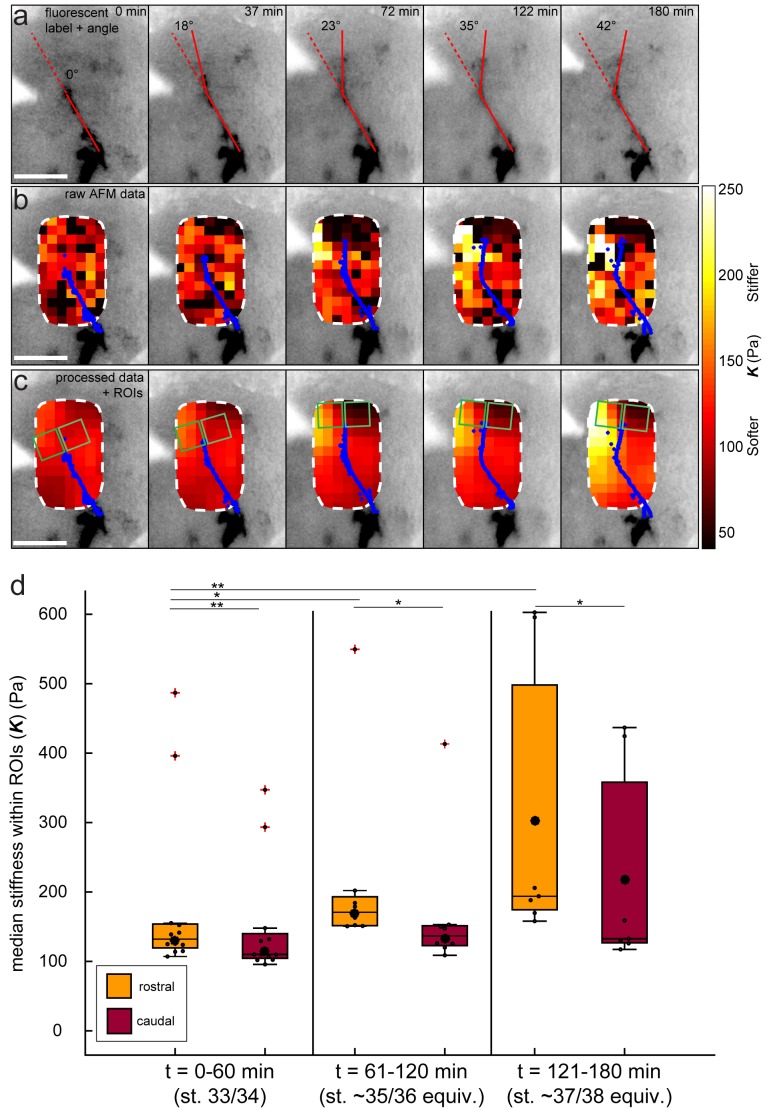
Data processing for tiv-AFM experiments.(a–c) Same Xenopus embryo shown in Figure 2a–b. (a) Inverted epifluorescence raw images of OT axons (black) acquired during tiv-AFM measurements, labelled with membrane-bound GFP under the control of the cell type-specific ath5 promoter, showing turn angles (overlaid red lines). (b) Overlaid tiv-AFM-based colourmaps (‘stiffness maps’), encoding raw values of apparent elastic moduli K, with OT axons outlined in blue. Black squares denote points where AFM data were not analysable. (c) Final stiffness maps used for mechanical gradient quantification. To generate these maps, missing K values were interpolated and data were smoothed in x-, y-, and t-dimensions using an algorithm based on the discrete cosine transform (cf. Figure 1d; for more details see Materials and methods). Regions of interest used to calculate stiffness gradients immediately in front of the advancing OT axons are overlaid on the stiffness maps (green squares). (d) Boxplot of absolute K values obtained in rostral and caudal ROIs (pooled for all N = 6 embryos at all time points), binned over the same time ranges shown in Figure 2c (i.e. 0–60 min – stage 33/34 equivalent; 60–120 min – stage 35/36 equivalent; 120–180 min – stage 37/38 equivalent). Rostral stiffness is already significantly higher than caudal at 0–90 min (p=0.002, Mann-Whitney test), and continues to increase rapidly over the time course, along with the consequent stiffness difference between the two ROIs. Boxplots show median, 1 st, and third quartiles; whiskers show the spread of the data; red crosses denote outliers; ‘o’ indicates the mean. *p<0.05; **p<0.01; AFM measurement resolution, 20 µm; all scale bars, 100 µm.